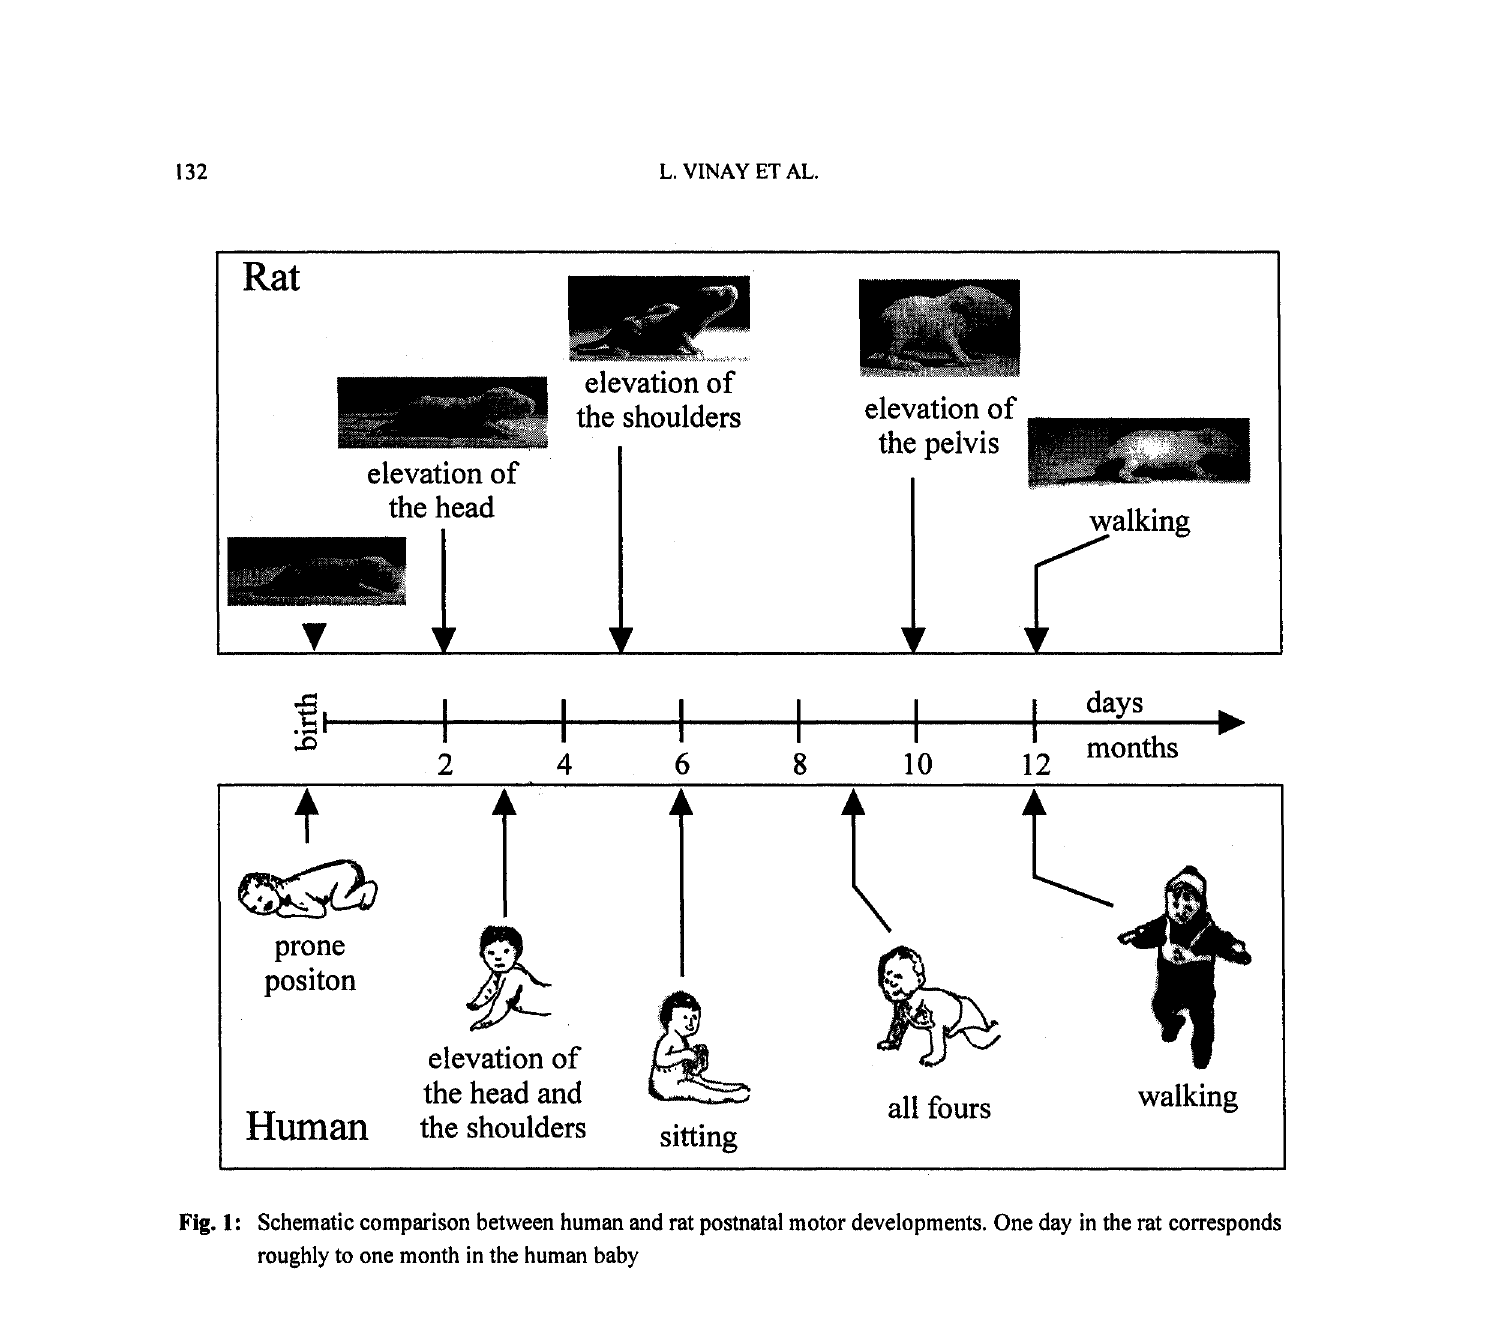
pattern generators (CPGs) in the spinal cord